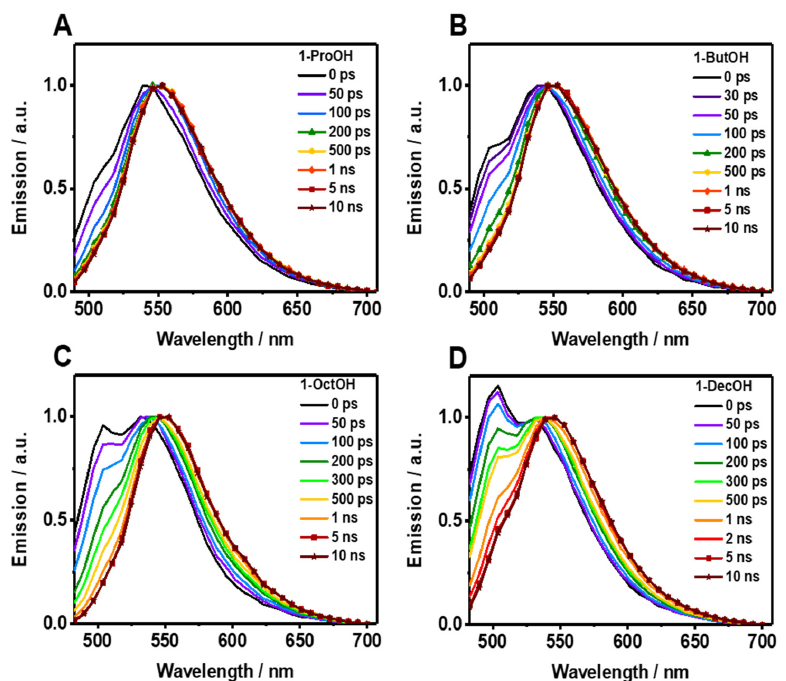
Figure 4. Picosecond time-resolved emission spectra (TRES) of Me 2 CANADC in ( A ) 1-ProOH, ( B ) 1- ButOH, ( C ) 1-OctOH, and ( D ) 1-DeOH at different delays as indicated in the inset. The spectra were normalized on the 550 nm band.